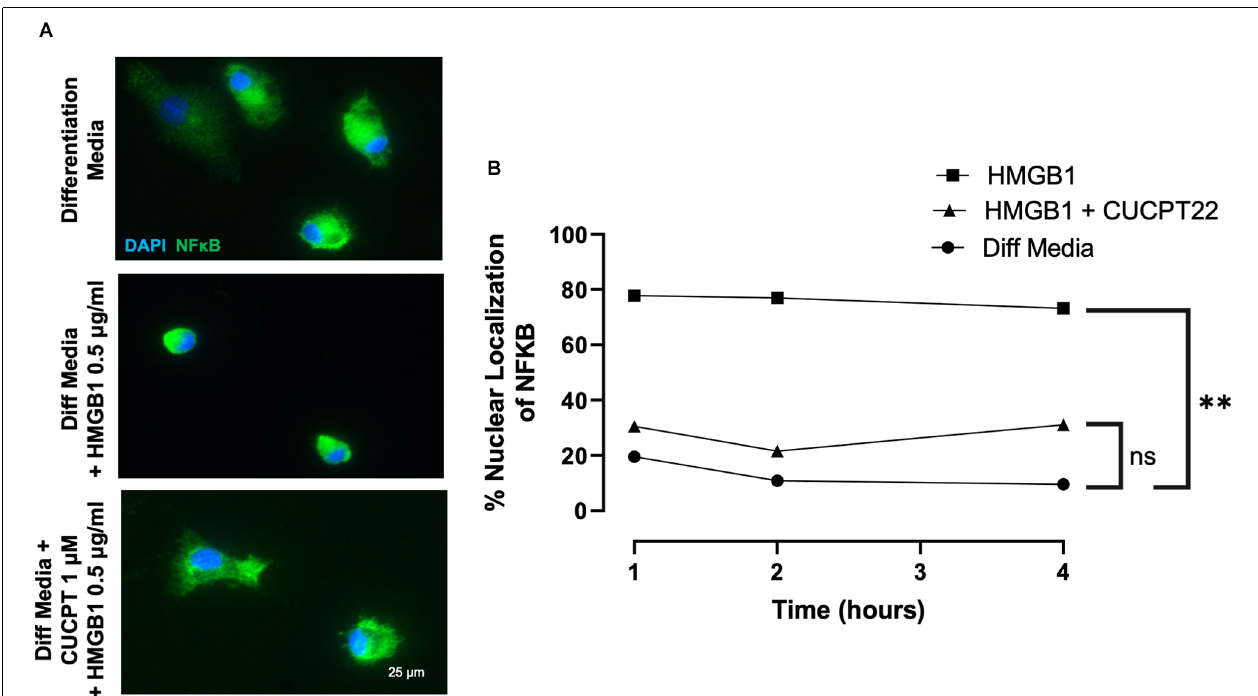
FIGURE 5 | HMGB1 promoted nuclear localization of NF κ B after HMGB1 treatment. (A) Immunocytochemical detection of NF κ B in primary OPC cultures identified NF κ B to be predominantly in the cytoplasm of control, differentiating cells, but was observed to be rapidly localized to the nucleus when exposed to HMGB1. Addition of the TLR2 inhibitor, CU CPT22, prevented the nuclear localization of NF κ B in HMGB1-treated OL lineage cells. (B) Quantification of the percent of OL lineage cells with nuclear localization of NF κ B over time. Analyzed by repeated measures ANOVA, where ∗∗ P ≤ 0.01; and ns when P > 0.05. Scale bar = 20 µ m.